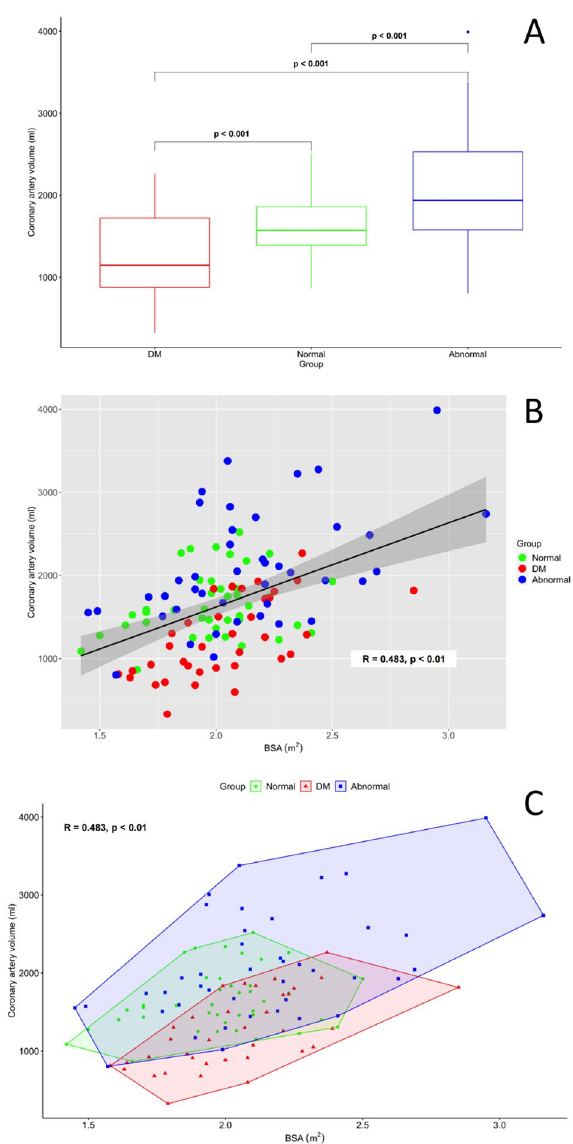
Figure 1. Panel A —The quantification of total coronary artery volume (LAD + LCX + RCA + LMCA) for three populations with non-atherosclerotic diabetic, normal, and dilated coronary disease. Panel B —The correlation of total coronary artery volume with body surface area (BSA m 2 ) with groups identified by colour (diabetes = red; normal = green; abnormal = blue) with R = 0.48 ( p < 0.01). Panel C —Total coronary artery volume and BSA correlation with clustering of groups to identify distribution within groups. Abbreviations: BSA body surface area, DM diabetes mellitus, LAD left anterior descending artery, LCX left circumflex artery, LMCA left main coronary artery, RCA right coronary